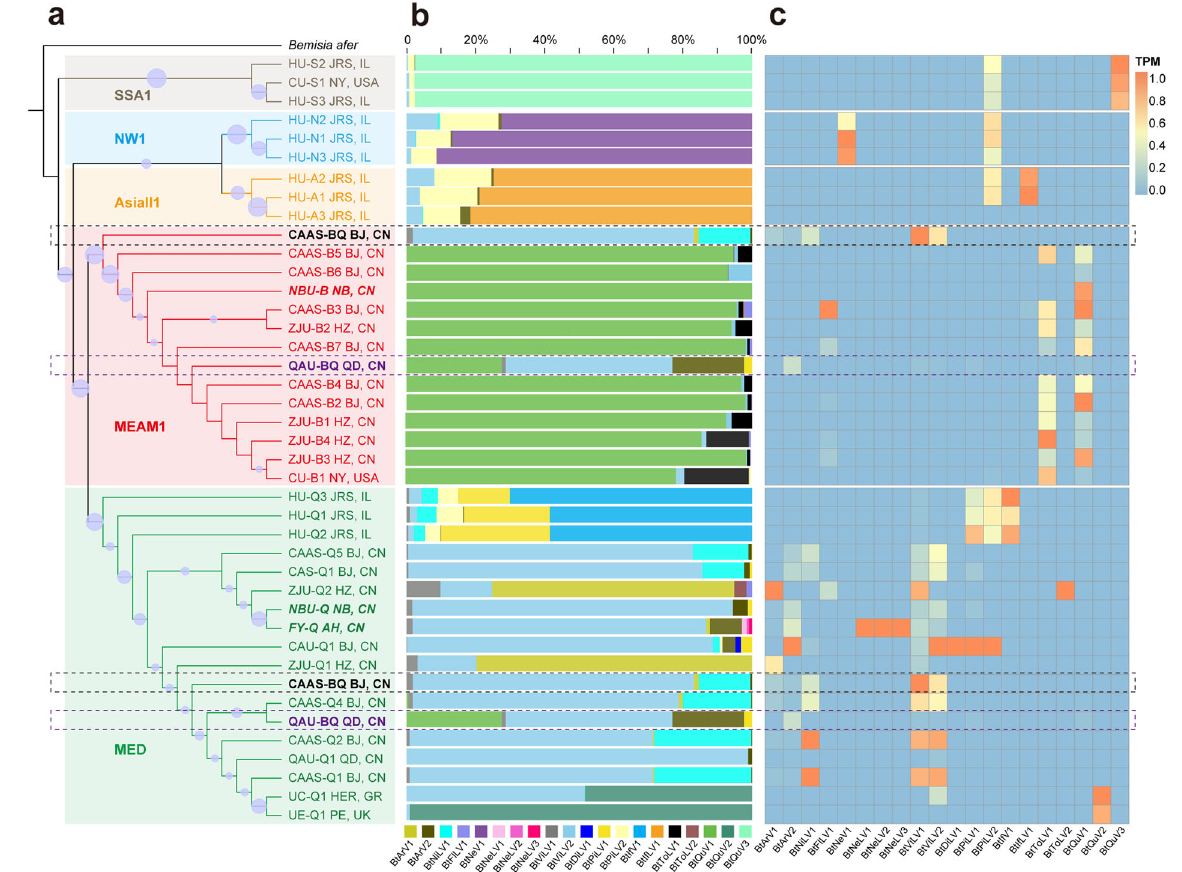
Fig. 3 Correlation between white fl y cryptic species and insect-speci fi c viruses. a Phylogeny of white fl y cryptic species based on mtCOI sequences using the maximum likelihood method. The mtCOI of Bemisia afer (MK360160.1) was used to root the tree. Two datasets (CAAS-BQ BJ,CN and QAU-BQ QD,CN) containing mixed cryptic species (MEAM1 and MED) are highlighted by dotted frames colored with black and purple, respectively. Nodes with bootstrap values >50% are marked with solid blue circles. b Composition of insect-speci fi c viruses (ISVs) in each white fl y cryptic species dataset. ISVs are color-coded and the names of viruses are indicated at the bottom of the fi gure. c Relative abundance of ISVs across the different white fl y cryptic species datasets. The transcripts per million (TPM) of each ISV are displayed by the heat map. Abbreviations of the cities and countries: JRS, IL: Jerusalem, Israel; NY: New York, USA; AJ, IN: Ajitgarh, India; BJ, CN: Beijing, China; NB, CN: Ningbo, China; HZ, CN: Hangzhou, China; QD, CN: Qingdao, China; AH, CN: Anhui, China; HER, GR: Heraklion, Greece; PE: Penryn. Abbreviation and details of the white fl y datasets and newly discovered ISVs are listed in Tables 1 and 2, respectively. Abbreviations of the white fl y cryptic species: MEAM1 Middle East Asia Minor 1, MED Mediterranean, NW1 New World 1, SSA1 sub-Saharan Africa